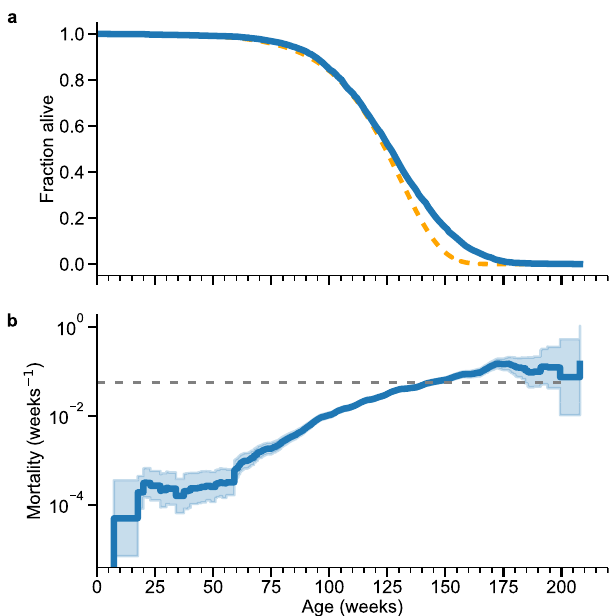
Fig.4|Late-lifemortalitydecelerationinmice.a TheKaplan-Meiersurvivalcurve (solid blue line) in female mice cohorts from ref. 25. The orange dashed line represent the best Gompertz fi ts. b The Nelson – Aalen estimator of total mortality (solidblueline)andthe95%con fi denceintervalsare fi lledinblue.Thegreydashed line corresponds to the mortality level according to the theoretical predic- tion M ð t ≫ (cid:2) t Þ = α